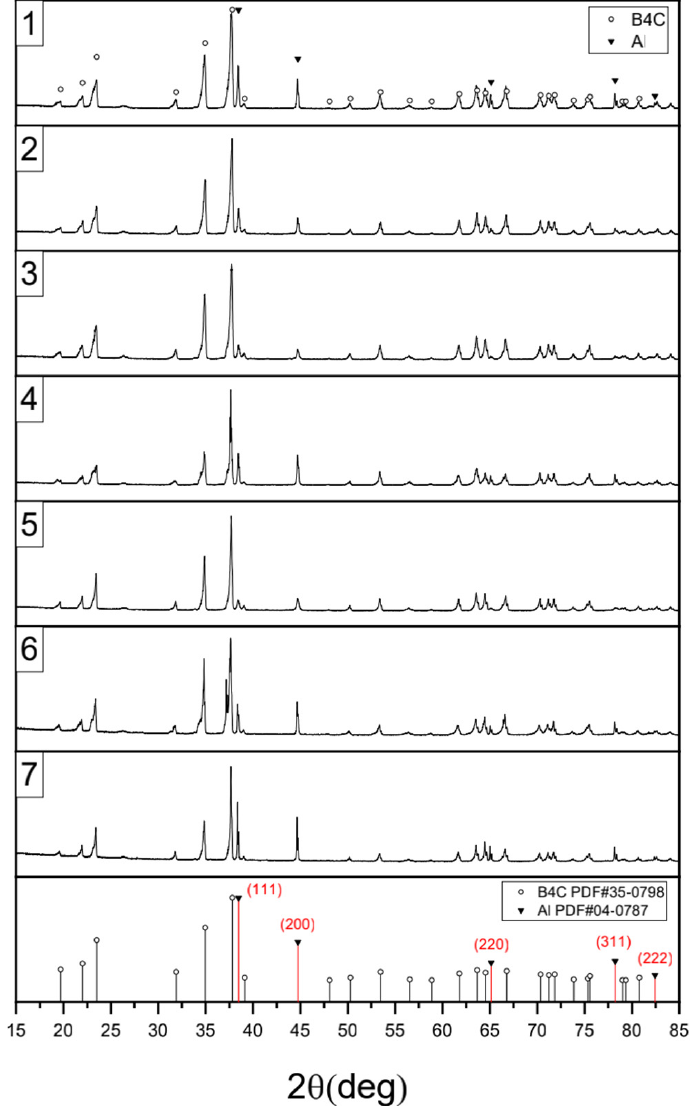
Figure 3. XRD analyses of samples in Table 2.